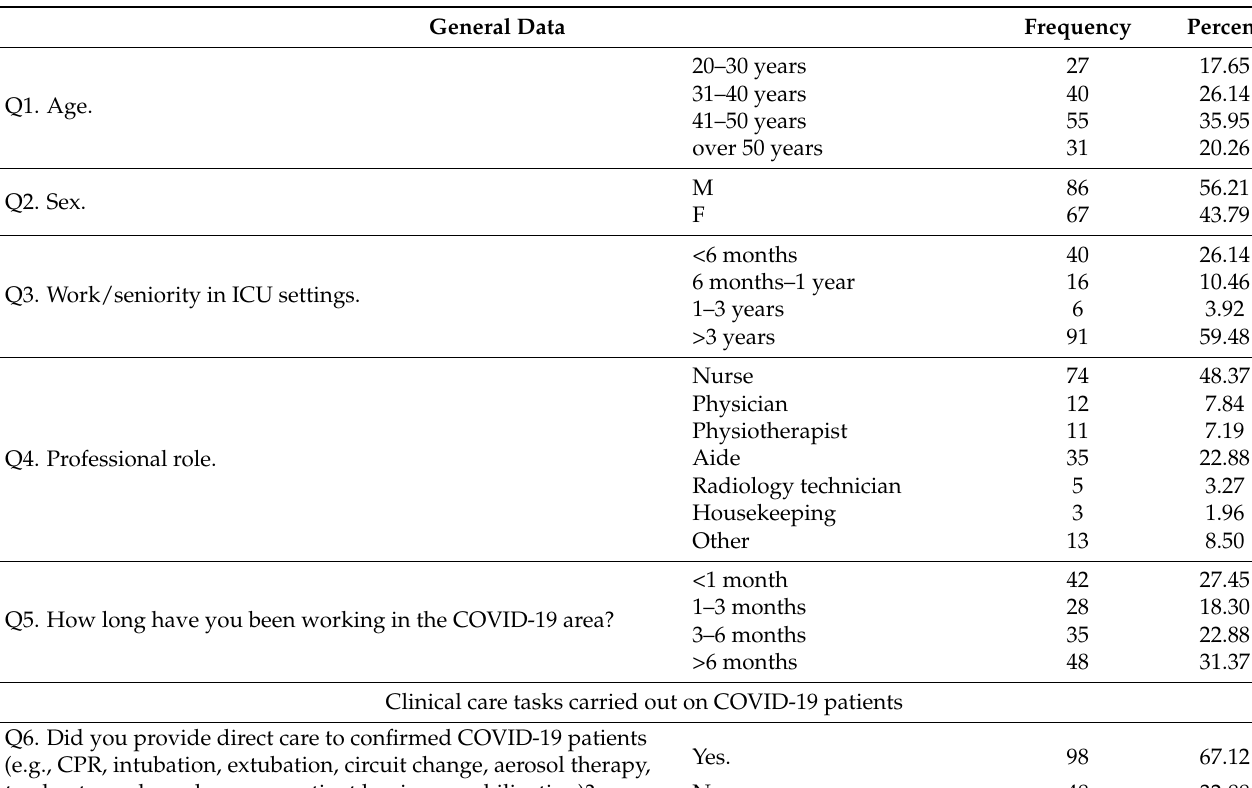
Table 2. Questionnaire and